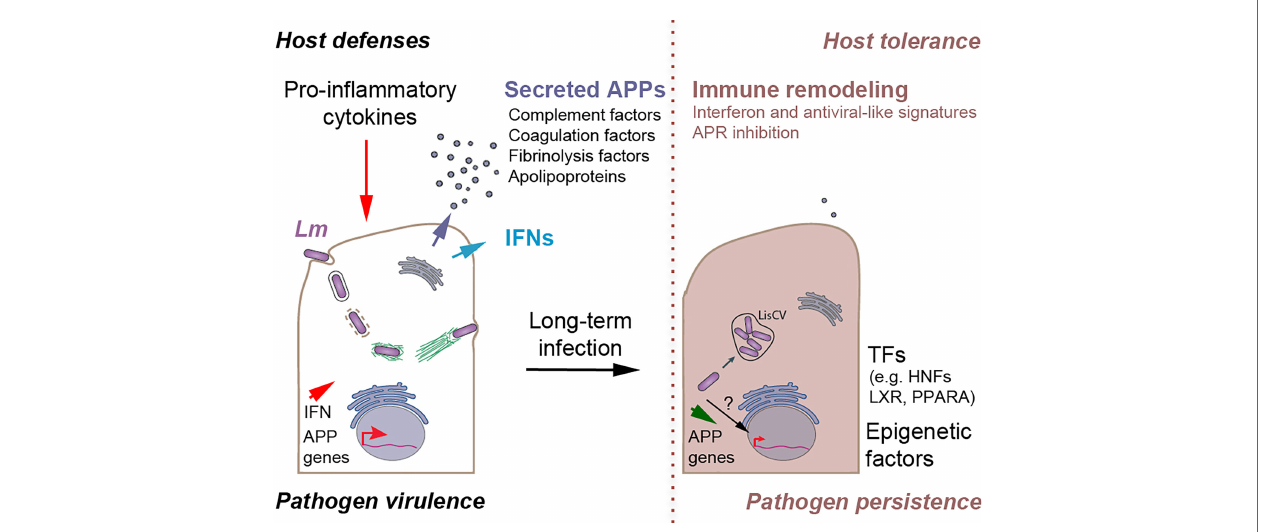
FIGURE 8 | Proposed model of Listeria- mediated immune remodeling to promote persistent infection in hepatocytes. Acute infection (left). L. monocytogenes (Lm) invades hepatocytes (through the InlA/B-mediated entry pathways or through cell-to-cell spread from infected macrophages, not represented). During the active phases of the infection process, Lm produces virulence factors that enable bacteria to enter into the cytosol and spread from cell-to-cell by the ActA-mediated actin-motility process. Hepatocytes detect intracellular Lm and secrete type I/III interferons (IFNs) and other cytokines (not represented), stimulating immune cells. In turn, immune cells secrete pro-in fl ammatory cytokines, such as IL-6 and IL-1 b , which activate the expression of genes encoding acute phase proteins (APP) in hepatocytes. Secreted APPs, which include complement, coagulation and fi brinolytic factors and a set of apolipoproteins, have antimicrobial and/or immunomodulatory effects that contribute to the clearance of Listeria infection. Persistent infection (right). Long-term Lm infection exacerbates interferon and anti-viral like responses and imposes a block on APP gene expression in hepatocytes, by an unknown mechanism possibly involving the inhibition of transcription factors (e.g. hepatocyte nuclear factors (HNFs), LXR, PPARA) and epigenetic regulators, leading to the decrease in APP secretion and inhibition of the APR. Concomitantly, bacteria stop expressing ActA and are engulfed in membrane compartments to form Listeria -containing vacuoles (LisCV), where they enter a persistent non-replicative phase. The deregulation of the hepatocyte-speci fi c innate immune responses prevents the complete elimination of Listeria in the liver, favoring the creation of a long-term reservoir of intracellular persistent bacteria. In addition, it could modulate adaptive immunity to favor the tolerance of cells harboring dormant